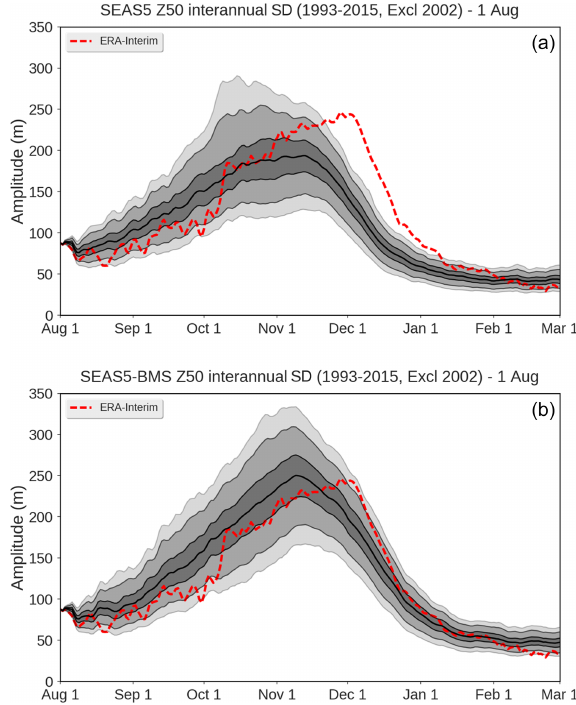
Figure 17. Polar-cap geopotential height interannual standard devi- ation for the SEAS5 default simulation (a) and the SEAS5 simula- tion using the BMS ozone model (b) ; simulations cover the period 1993–2015 (1 August start dates have been used). The year 2002 has been excluded. The red dotted line shows corresponding values from ERA-Interim. Solid black lines show the interannual standard deviation from the model experiments, and grey shaded regions cor- respond to the 1%, 5%, 25%, 50%, 75%, 95% and 99% threshold values for each day from 1 August until 1